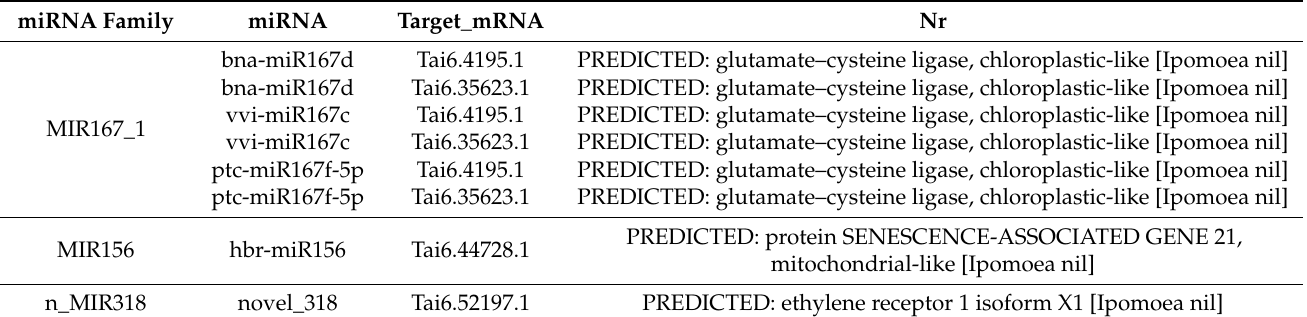
Table 4. The number of differentially expressed miRNAs in sweet potato after sweet potato weevil